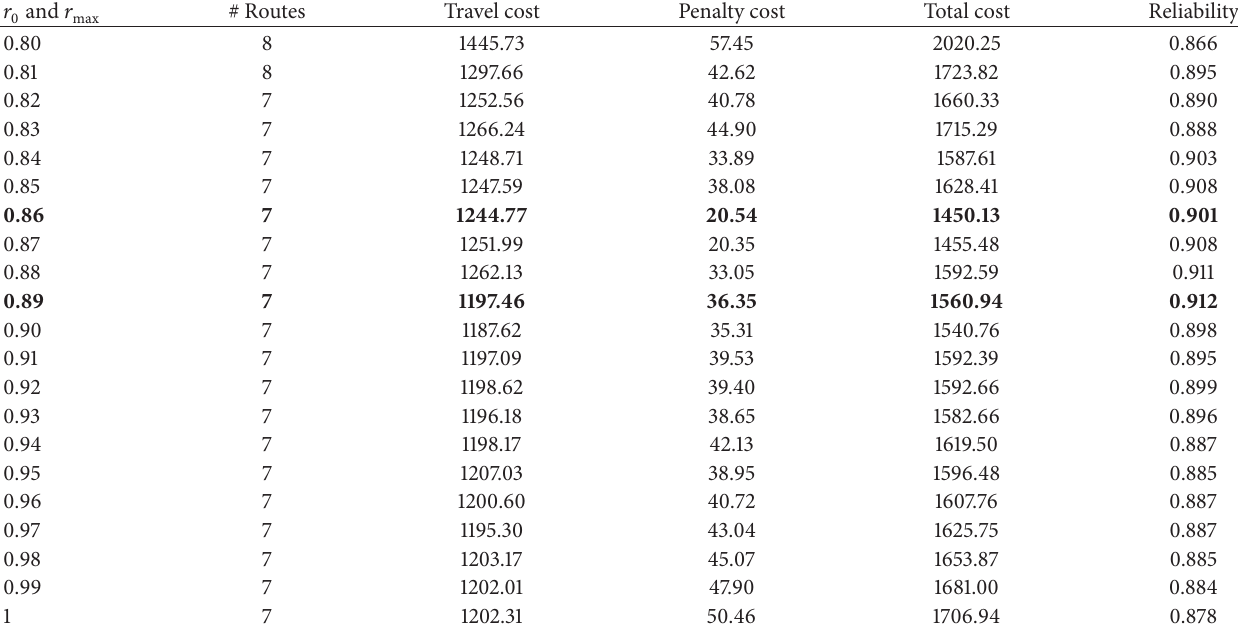
Table 2: Results of alternative solutions to the A-n54-k7 instance with medium